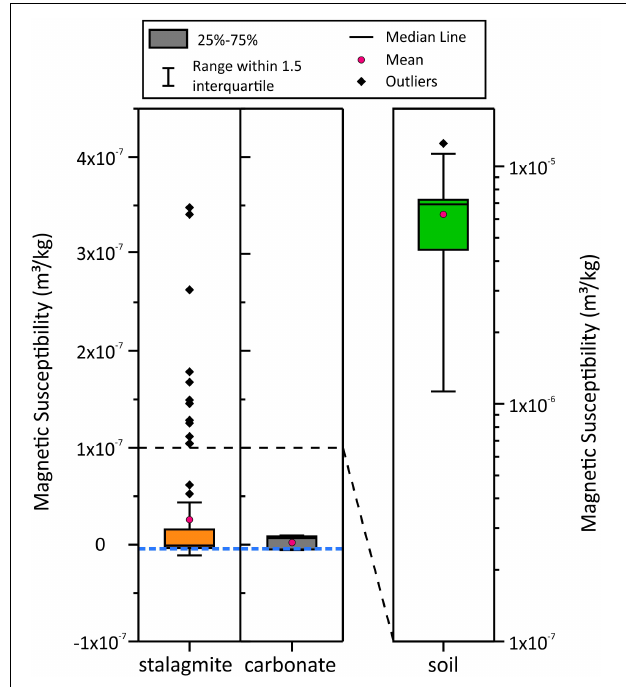
FIGURE 3 | Box plot of magnetic susceptibility results from stalagmite (orange), carbonate (gray), and soil (green); blue dashed line represents the pure calcite value (Schmidt et al.,